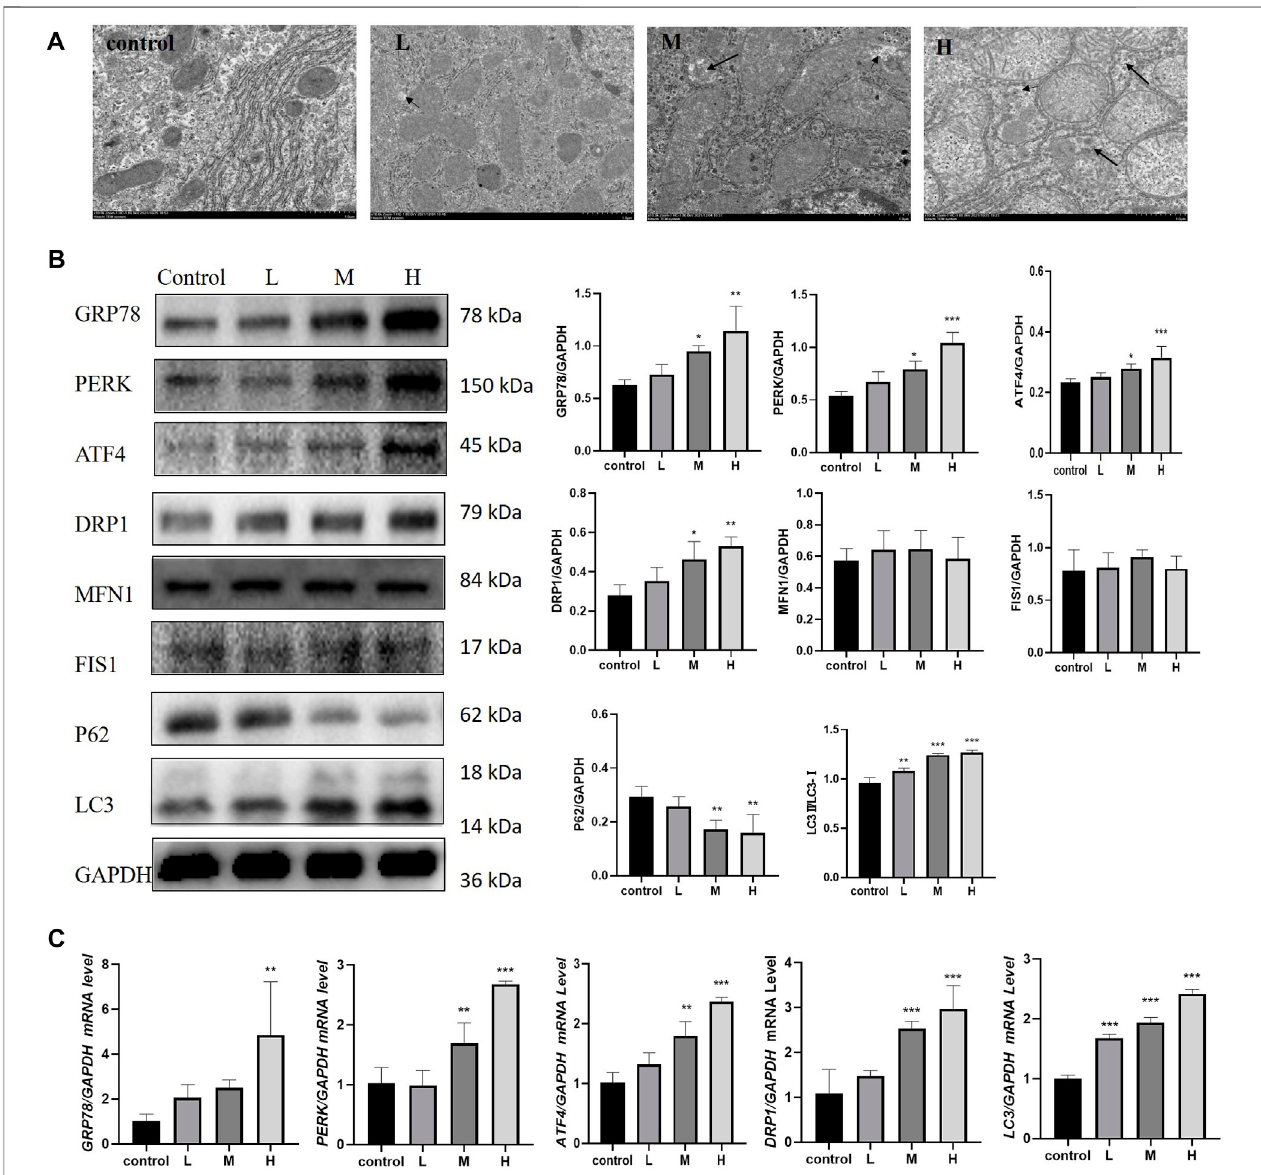
FIGURE 3 | TW induced excessive mitophagy and ERS in C57BL/6J mice. (A) TW caused mitochondrial and ER damage, mitochondrial swelling, vacuolization, cristae fragmentation, and increased autophagosomes and autophagolysosomes. The small black arrow represents autophagosomes, and the large black arrow represents autophagolysosomes.10,000magni fi cation,Scalebar:1 µm. (B) TW-inducedchangesintheexpressionofmitophagyandERS-relatedproteinsGRP78,PERK,ATF4,DRP1,MFN1, FIS1,P62,andLC3. (C) TW-inducedchangesinmRNAlevelsof GRP78,PERK,ATF4,DRP1 ,and LC3 .Comparedwiththecontrolgroup, *p < 0.05,**p < 0.01,***p <